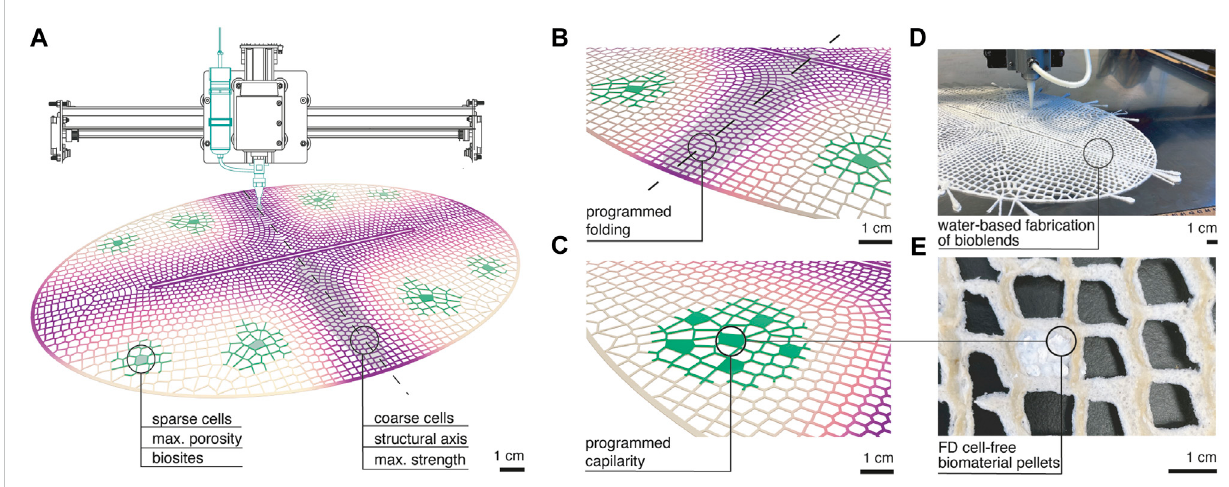
FIGURE 3 Mesoscale design methodology (A) Additive manufacturing is used to functionally distribute fi brous biopolymer blends in 50 cm long lattices with varied cell size and material composition. Geometrical design and material composition is graded throughout the lattice to target two distinct behaviors. Biositesareplacedwheremaximumporositymaterialislaidandinpresenceofsparsecellareasrangingfrom5to8 mm.Structuralshortaxisoftheovalis designedwithcoarsecelldistributionof1 – 4 mmandmadebystrongermaterialblends. (B) Programmedfoldingandstrengthinthestructuralaxisis given by maximum shrinkage of the region because of higher amount of material per unit area and of higher concentration of silk fi broin in the blend. (C) Programmed capillarity is given by aerated and shorter fi ber containing blends that improve porosity and fl uid travel from biosite to lattice. (D) Image of functionally graded lattices being printed from bioblends. (E) Image of abiosite embedded in the printed lattice made of freeze-dried cell-free in sodium alginate biopolymer.